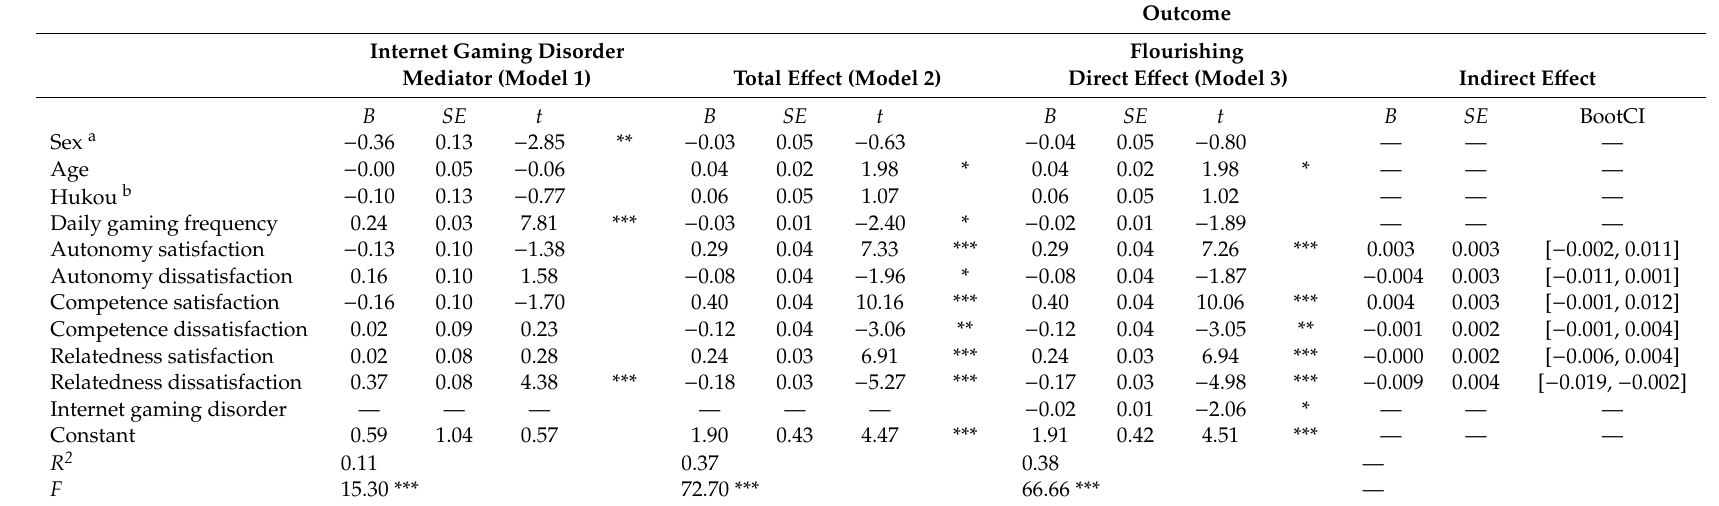
Table 2. Model Coe ffi cients for the Psychological Needs Mediation Analysis with Four Covariates ( N =